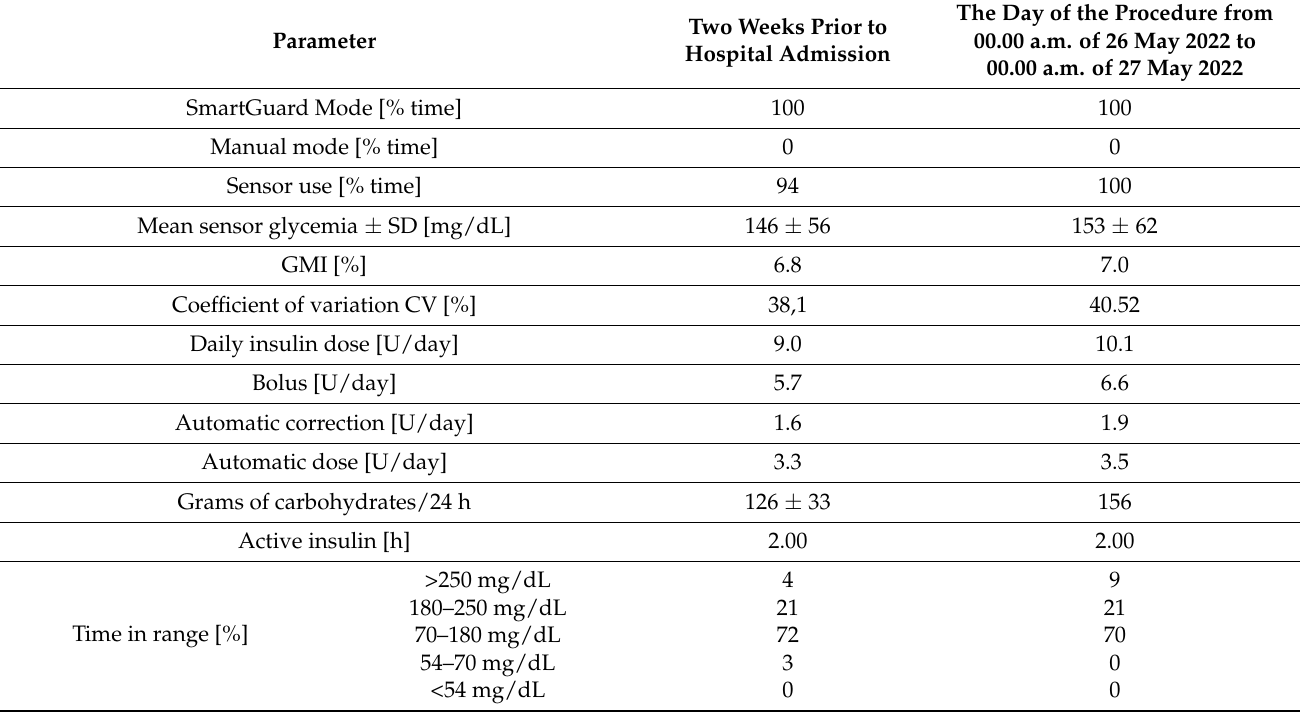
Table 2. AHCL report 2 weeks prior to hospital admission and on the day of the